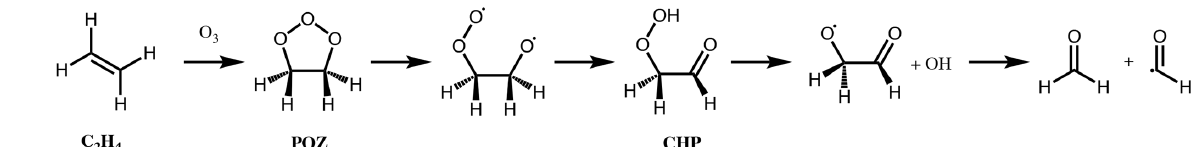
Figure 4. The carbonyl hydroperoxide (CHP) decomposition pathway for ethene